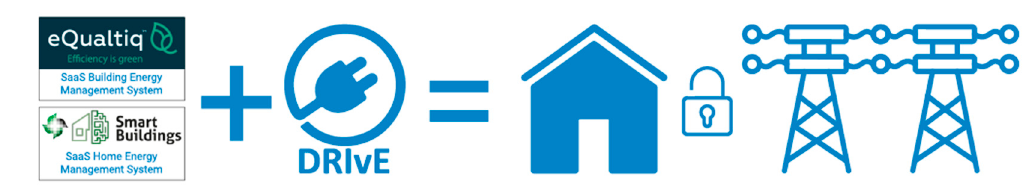
Figure 2. DRIvE unlocking DR potential.